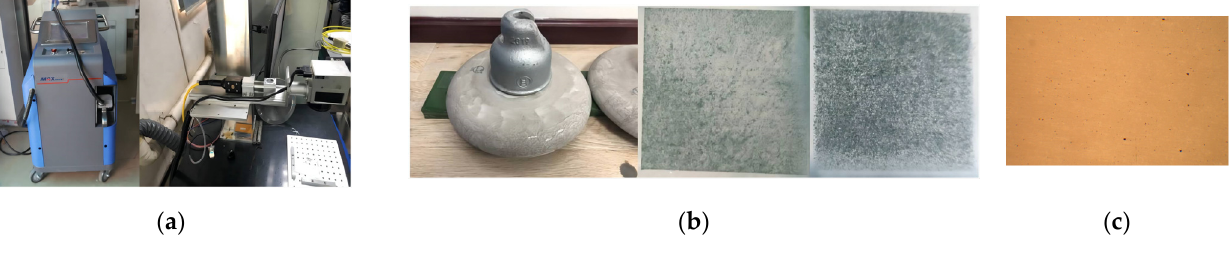
Figure 6. ( a ) Laser cleaning device; ( b ) Test samples; ( c ) Sample before laser